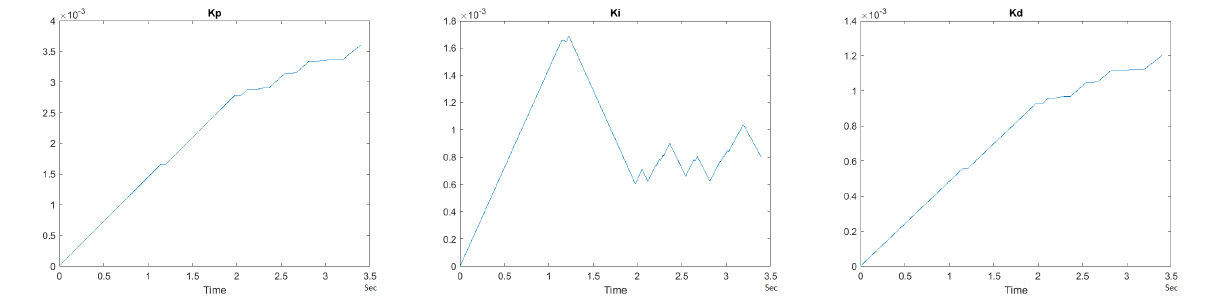
Figure 33. Kp , Ki and Kd parameters for PID++ UP– Vmax 120 cnts/ms, Adesired 0.055 cnts/ms 2 —10 g.